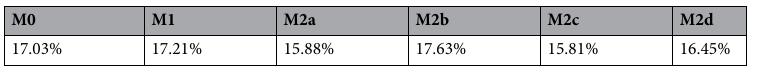
Table 2. A proportion of each polarization class used for the training